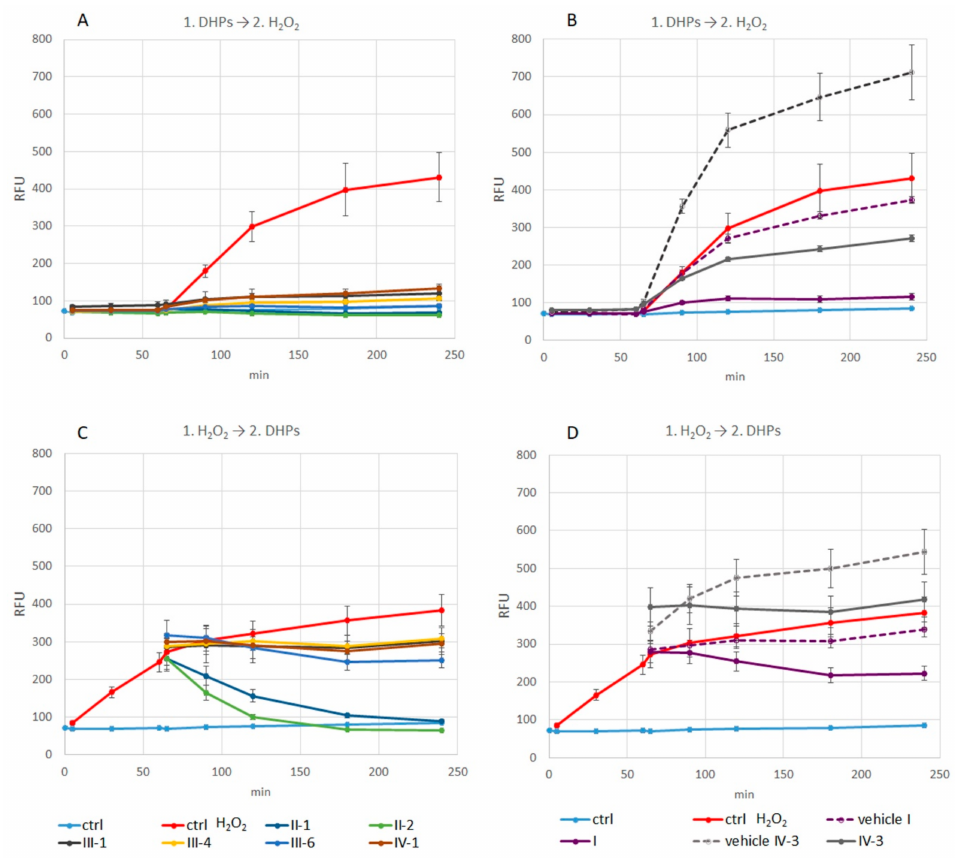
Figure 1. Intracellular ROS of HOS cells exposed to DHPs and H 2 O 2 .Cells were treated with DHPs and hydrogen peroxide, without the exchange of culture medium, as follows: ( A,B ) 1-h DHPs + hydrogen peroxide, or ( C,D ) 1-h hydrogen peroxide + DHPs. The fluorescence reflecting intracellular ROS levels was measured at different time points (0—no treatment, 5—immediately after the first treatment, 30, 60, 65—immediately after the second treatment, 90, 120, 180, 240 min). Results of DHPs (A,C—water-soluble; B,D—soluble in organic solvents) are presented as mean of relative fluorescence units (RFU) ± standard deviation (n = 2). Controls: ctrl (untreated cells), ctrl H 2 O 2 (cells treated with hydrogen peroxide) and solvent-controls (vehicle Diethone I and vehicle E3-46 IV-3